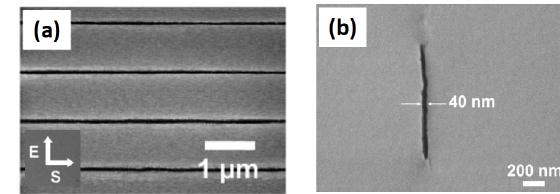
Figure 8: SEM images of (a) an array of single nanogrooves with widths less than 40 nm fabricated on ZnO [56]. Reproduced with permission from The Optical Society of America, © 2014 by The Optical Society of America. (b) Cross-sectional SEM image of a nanochannel with a width of about 40 nm and a depth of about 40 µ m (aspect ratio: ca. 1000) formed inside porous glass by abla- tion in water